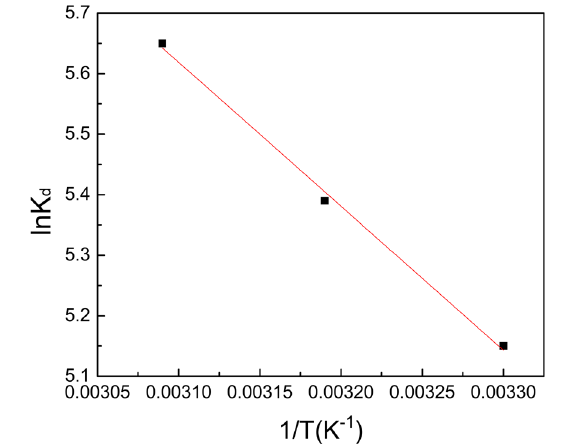
versus 1/T for methylene blue d